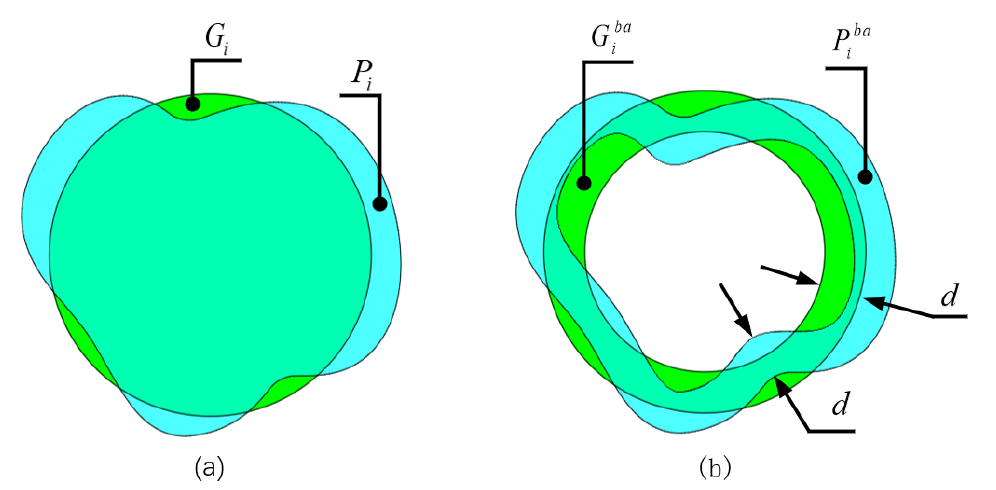
Figure 3. ( a ) The prediction results and ground truth of the i -th category. ( b ) The prediction result of the i -th class and the edge area of the ground truth; d is the width of the edge area.